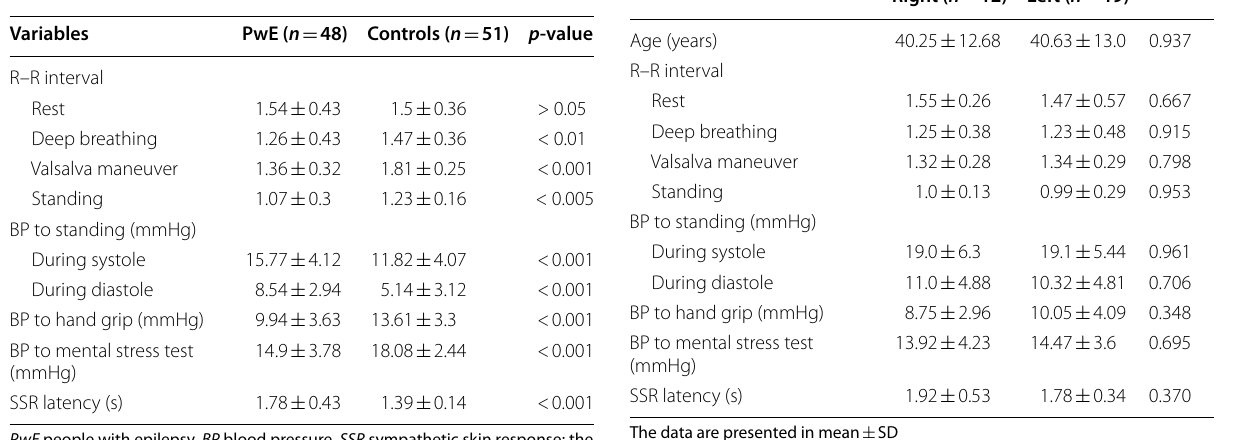
PwE people with epilepsy, BP blood pressure, SSR sympathetic skin response; the data are presented in mean